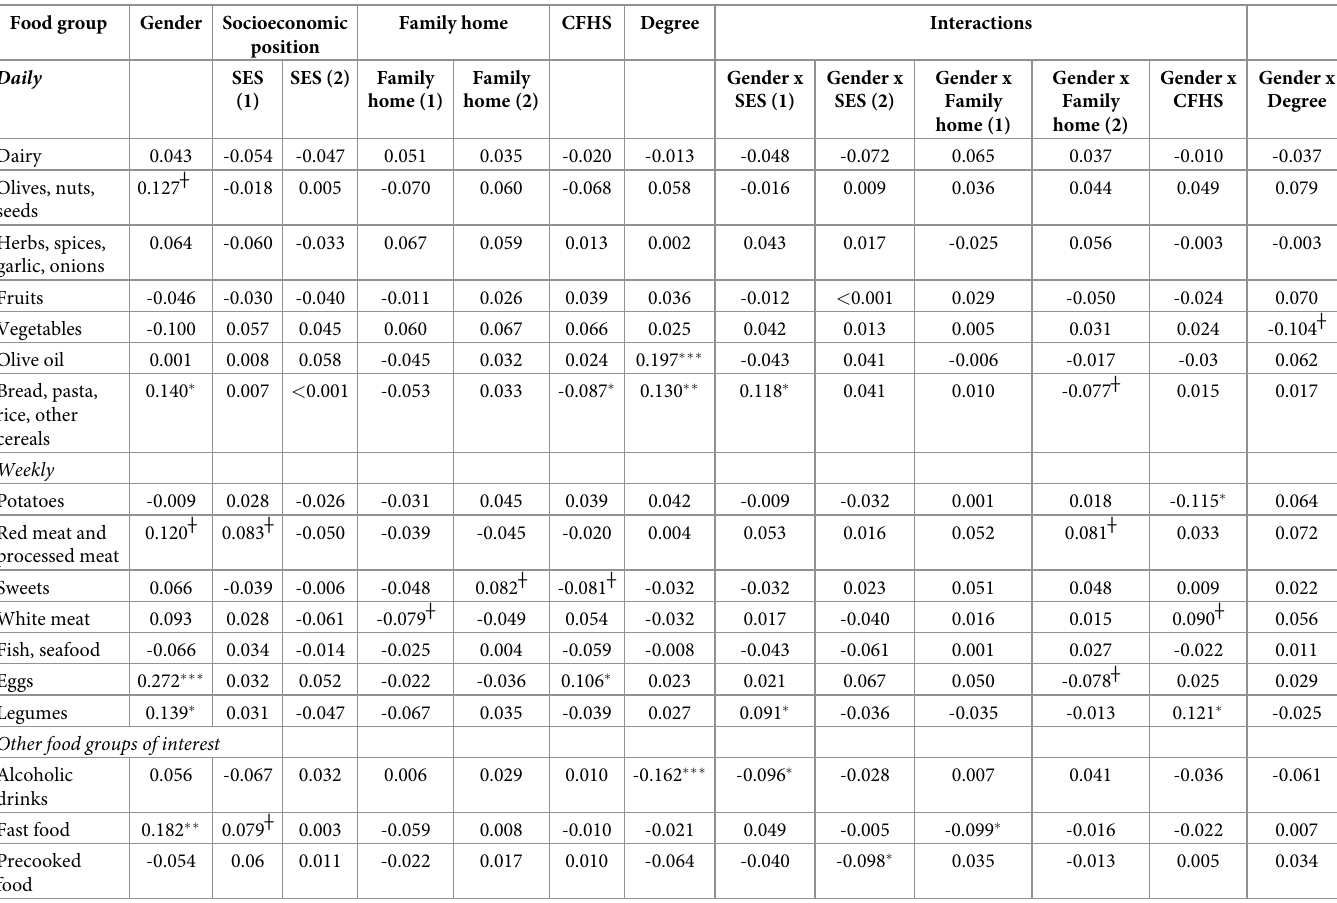
Table 8. Multiple regression analysis of food groups based on the Mediterranean diet pyramid, social determinants and interactions. Food